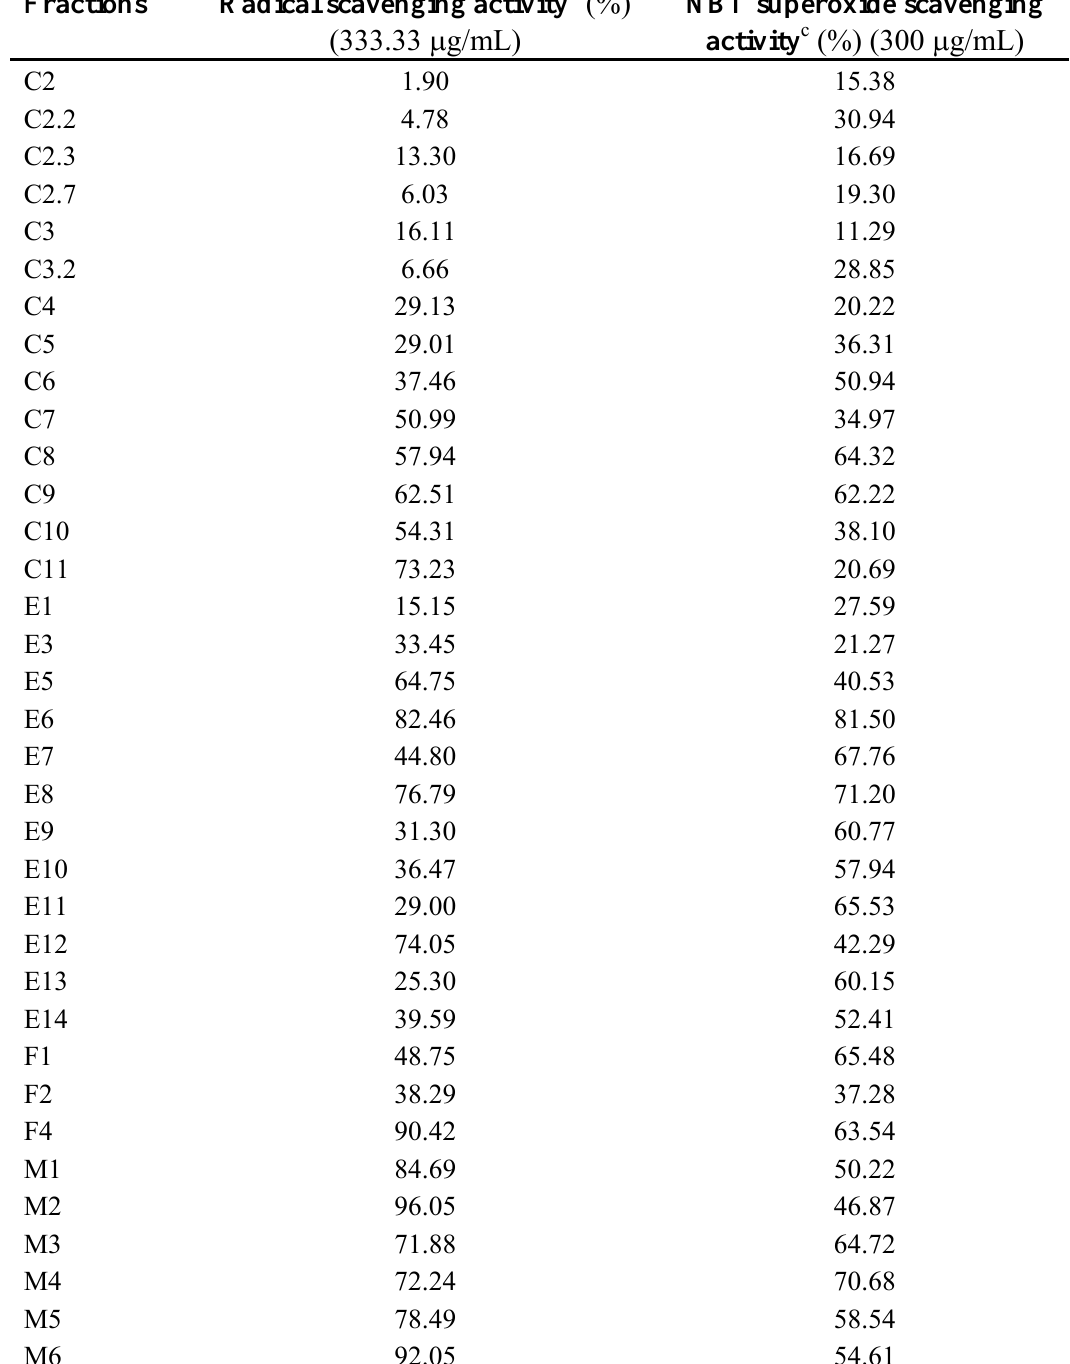
Table 3. Antioxidant activity of S. acmella Murr